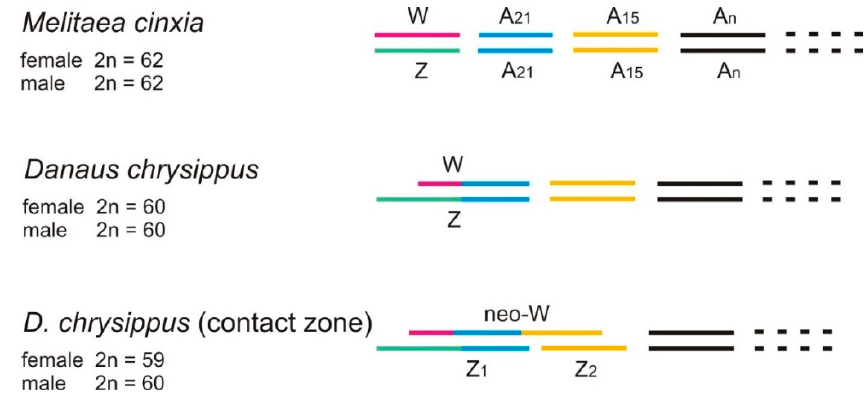
Figure 5. Composition of the sex chromosomes in the nymphalid model species M. cinxia and D. chrysippus . M. cinxia has the basic lepidopteran chromosome complement of W, Z and 30 pairs of autosomes (W, Z, A 2 , … A 31 ). In D. chrysippus the Z chromosome is a product of a fusion between the ancestral Z and a homologue of M. cinxia A 21 . Its partner A 21 has become the new W chromosome together with little or no part at all of the ancestral W chromosome. Variant females in the contact zone have neo-W chromosomes derived from a recent fusion between the D chrysippus W and a homologue of A 15 , and, hence, two Z chromosomes, Z 1 and Z 2 . Z 1 is the original D. chrysippus Z chromosome, Z 2 the free homologue of A 15 .